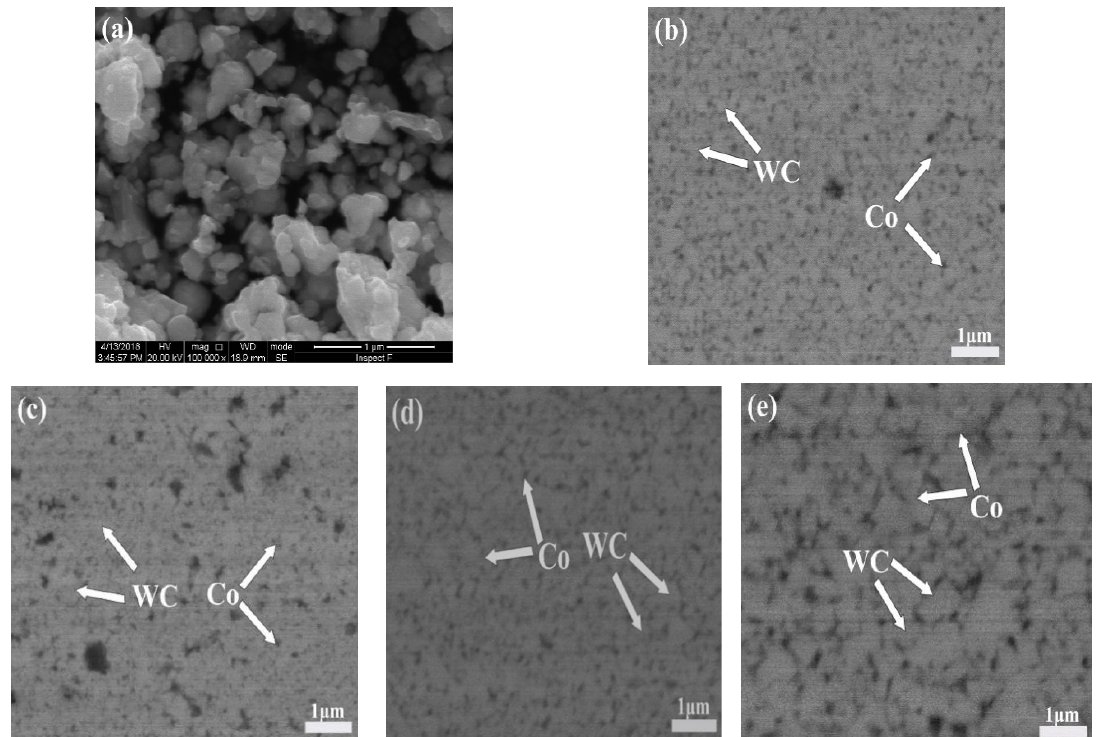
Figure 5. SEM images of ( a ) the composite powders; ( b – e ) specimens sintered at different sintering temperatures for 40 min (BSE mode); ( b ) 1100 °C; ( c ) 1200 °C; ( d ) 1300 °C; ( e ) 1400 °C.